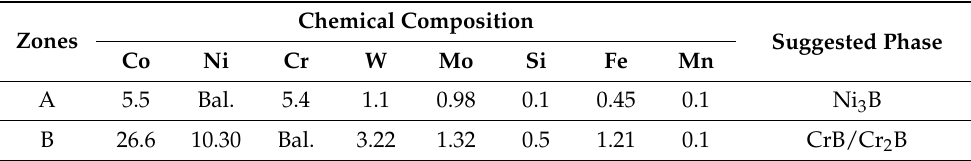
Table 6. EDX analysis of various phases indicated in Figure 16